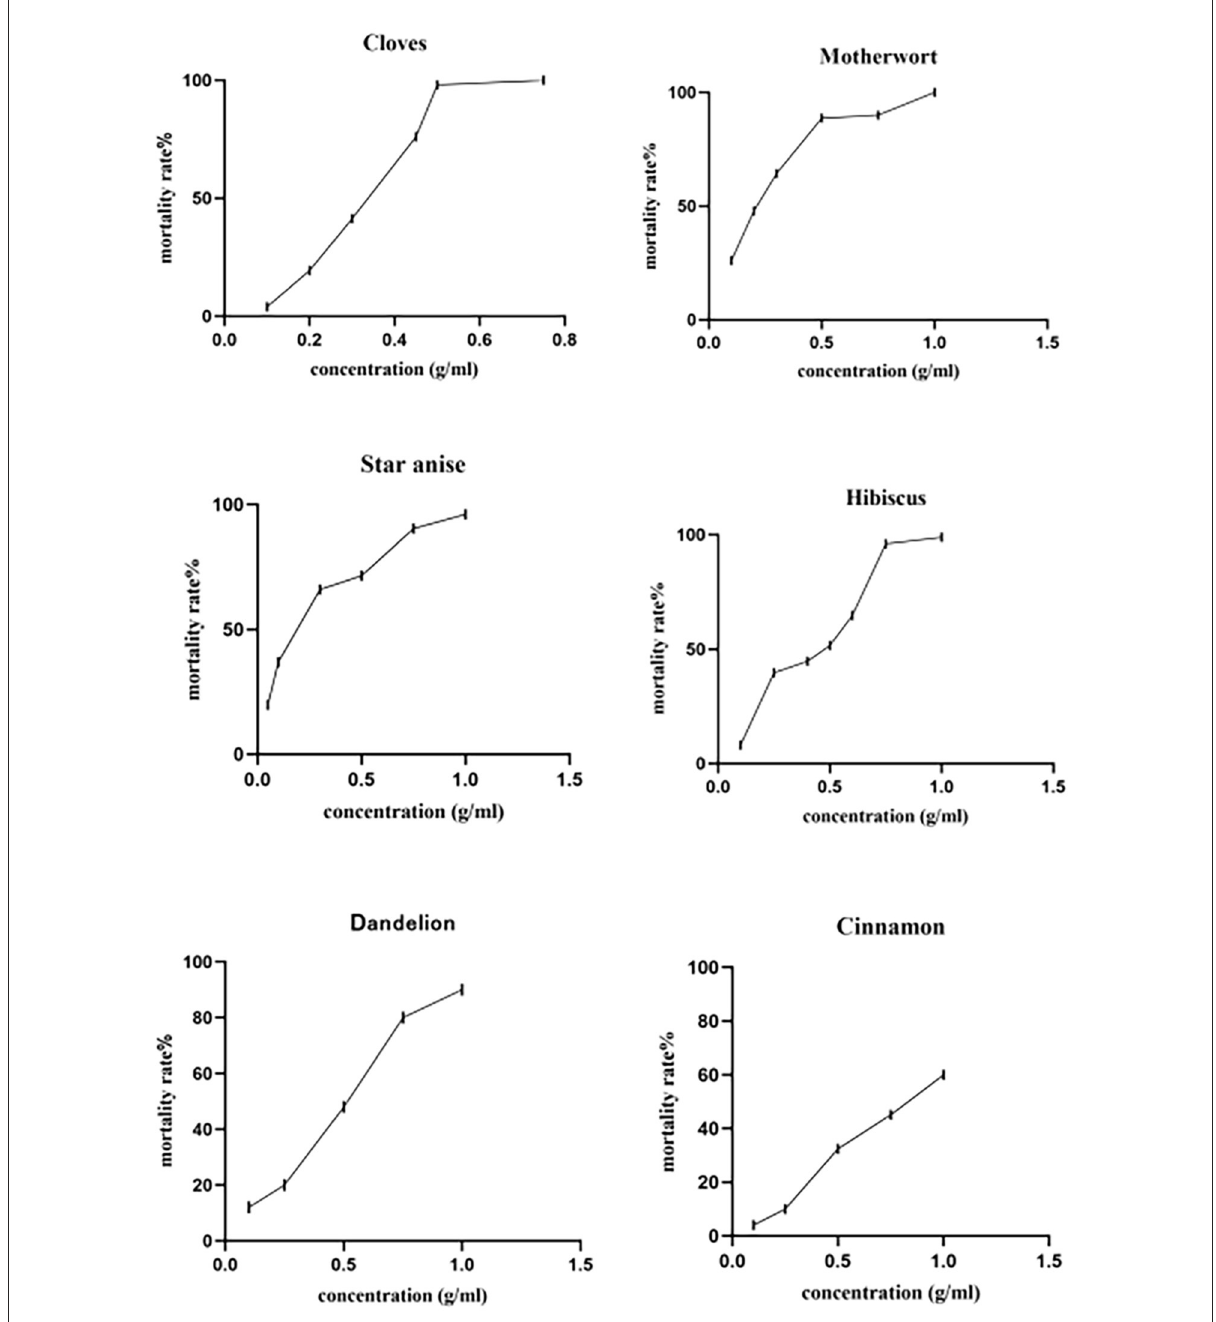
FIGURE1 Contact toxicity of alcohol extracts of Chinese herbal medicines against adult Dermanyssus gallinae .